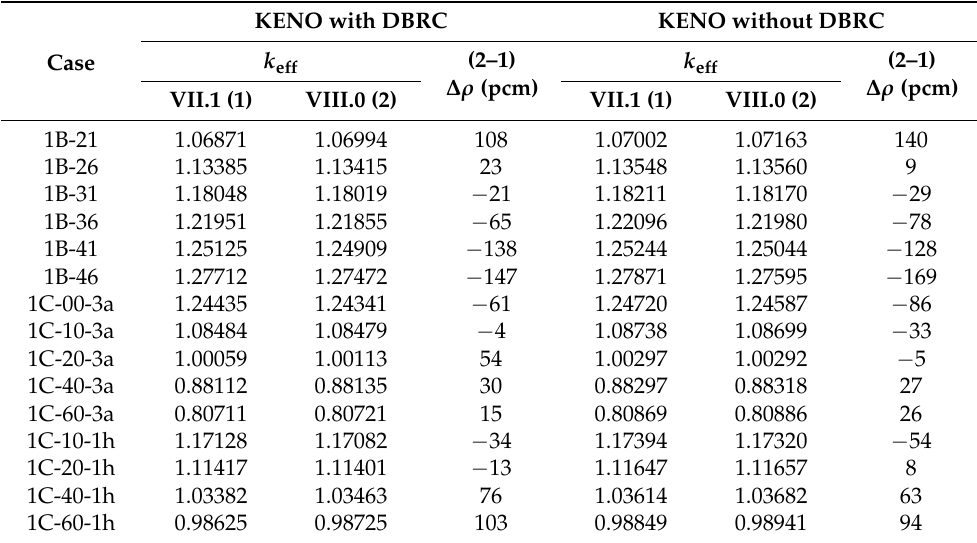
Table 6. Results of VERA PWR extended benchmark progression